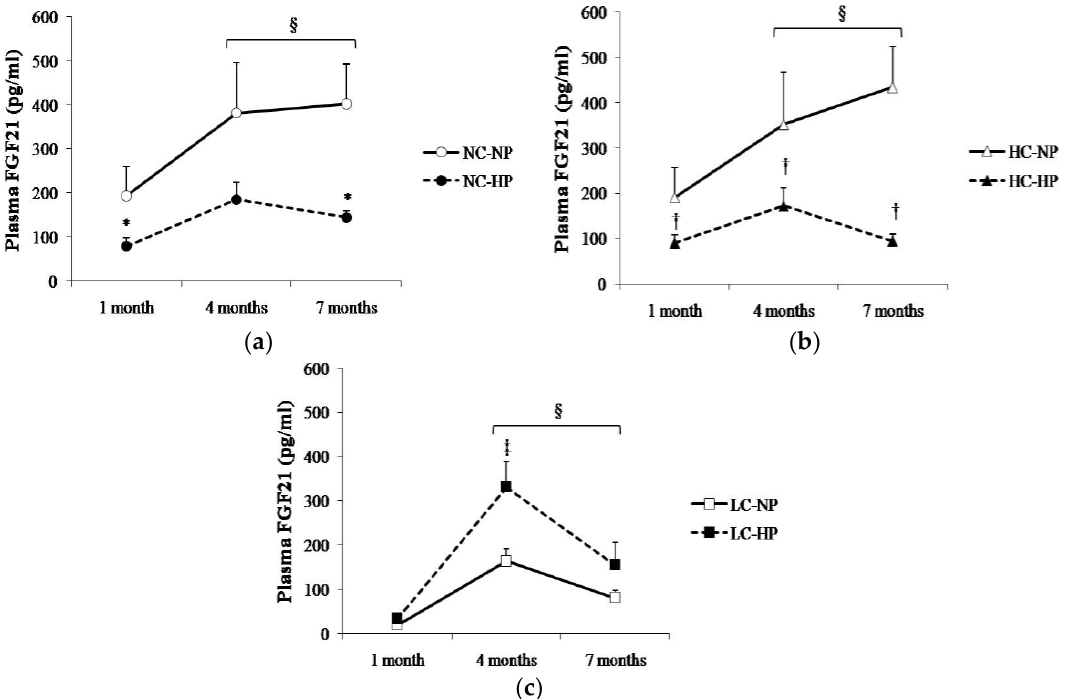
Figure 3. Plasma concentrations of fibroblast growth factor 21 (FGF21) at the three sampling times (1, 4 and 7 months) in rats fed diets with ( a ) normal calorie-normal phosphorus (NC-NP) and normal calorie-high phosphorus (NC-HP); ( b ) high calorie-normal phosphorus (HC-NP) and high calorie-high phosphorus (HC-HP); ( c ) low calorie-normal phosphorus (LC-NP) and low calorie-high phosphorus (LC-HP). n = 8 rats per group. * p < 0.05 vs. NC-NP, † p < 0.05 vs. HC-NP, ‡ p < 0.05 vs. LC-NP. § p < 0.05 vs. 1 month.